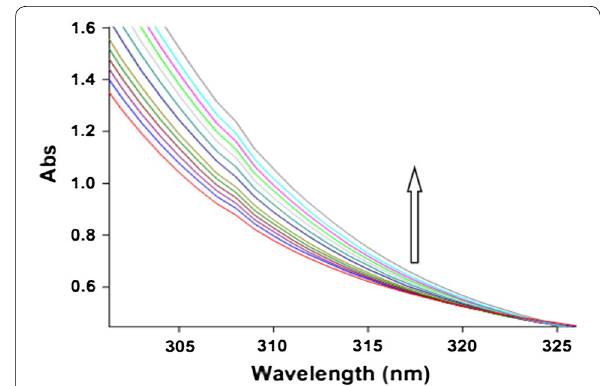
Fig. 3 Absorption changes versus wavelengths for the reaction between ( 1 ) (10 − 2 M), ( 2 ) (5 10 − 3 M) and (2) (10 − 2 M) in methanol × for the generation of product 3 at 5 min intervals up to 60 min; the upward arrow indicates the direction of the reaction’s progress